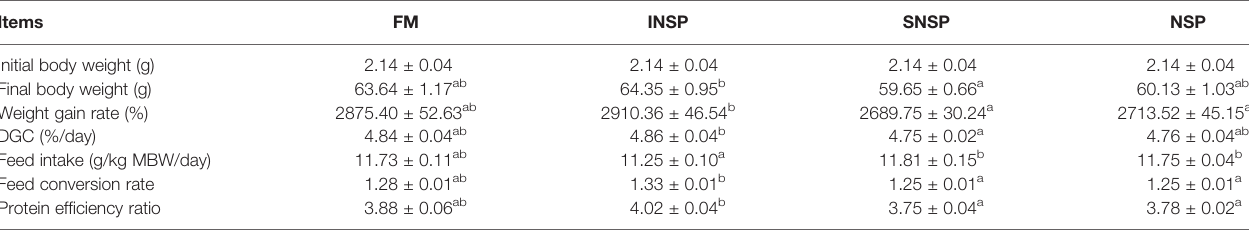
TABLE 2 | Growth performance and feed utilization of GIFT tilapia fed diets with different types of non-starch polysaccharides. Items